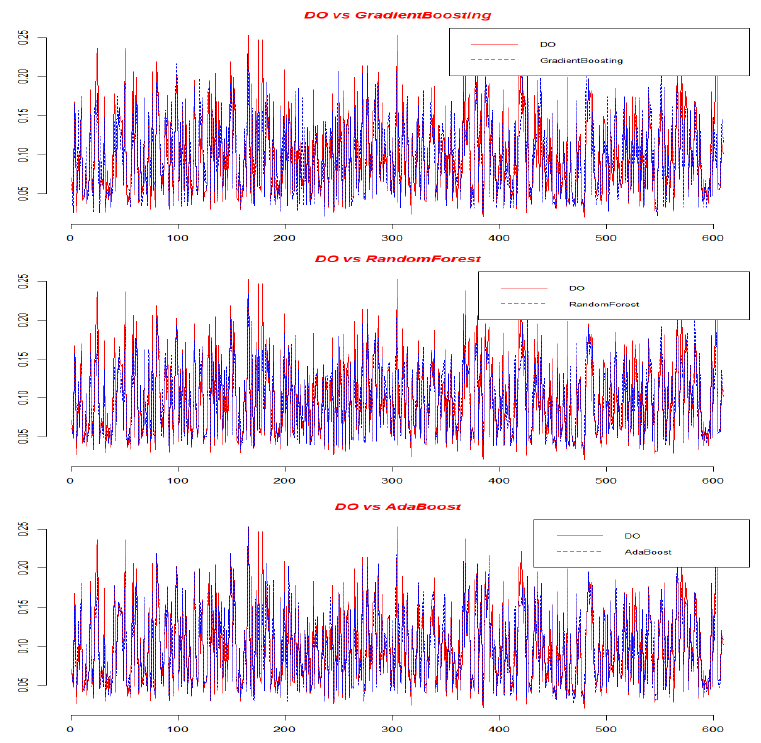
Figure 6. Prediction by models.